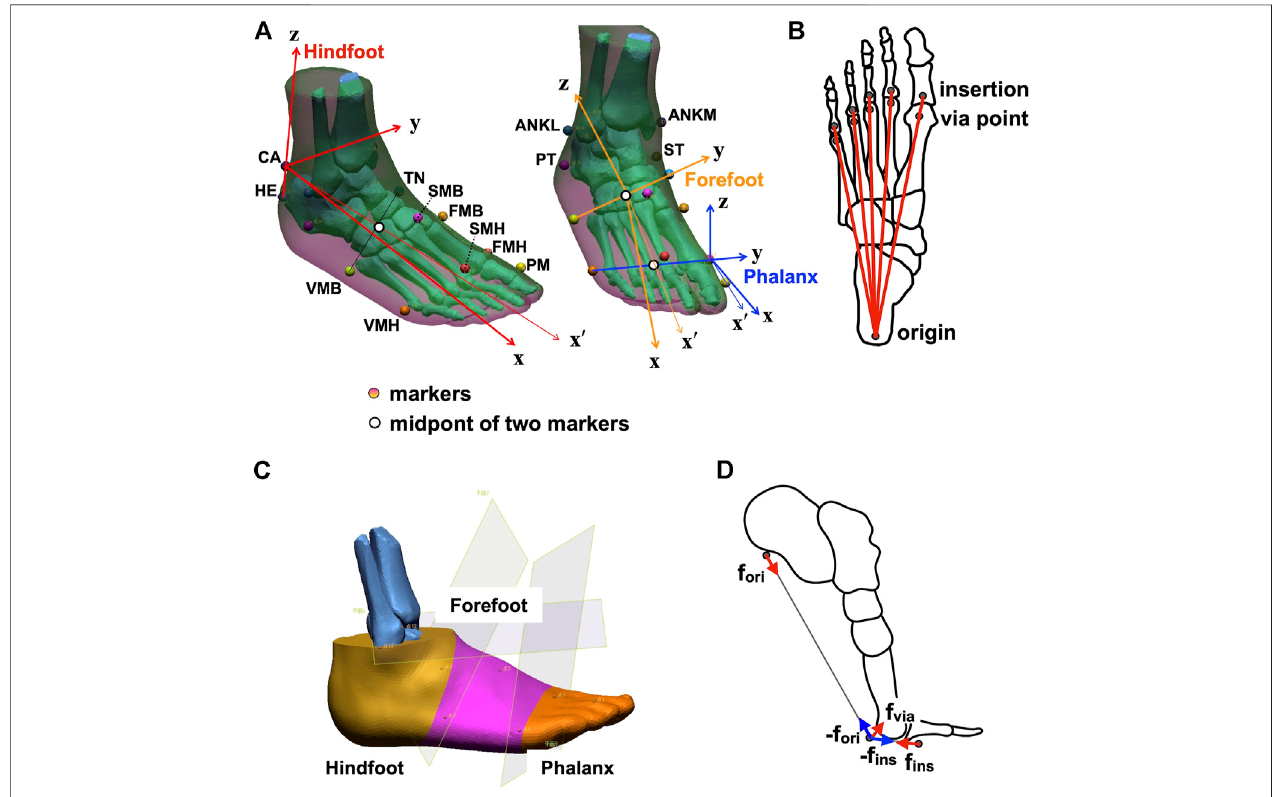
FIGURE1| Multi-segmentfootmodelincorporatingtheplantaraponeurosis(PA)fordetailedkinematicandkineticanalysesofthefoot. (A) Markerplacementsand thede fi nitionsofthecoordinatesystemsofthephalanx,forefoot,andhindfootsegments. (B) ThemodelofPA.ThePAwasmodeledas fi velinearspringsconnectingthe origin, via point, and insertion. (C) Segmentation of the phalanx, forefoot, and hindfoot segments. (D) Forces applied to the origin, via point, and insertions of the PA.